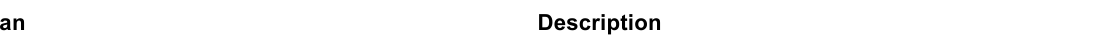
TABLE 1 - Preprogrammed scan numbers corresponding to scan tracings